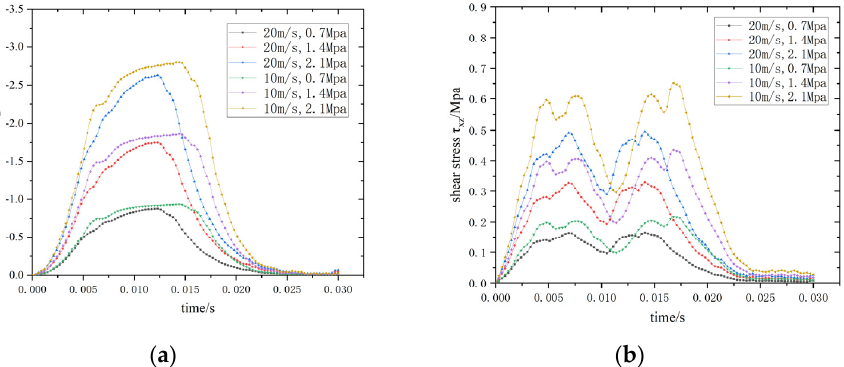
Figure 12. Maximum stress–time curve of elements at the interface under different driving conditions. ( a ) σ z -time; ( b ) τ xz -time.